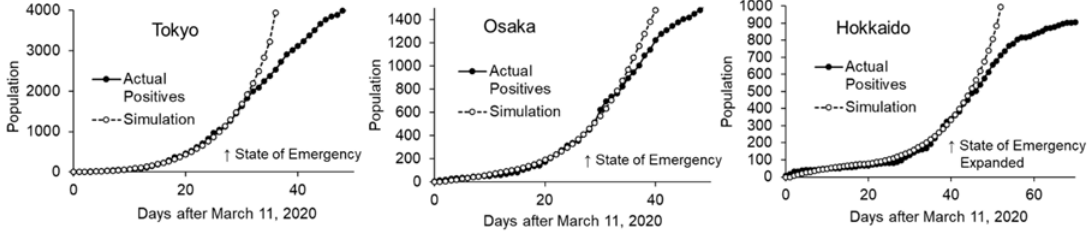
Figure 4. Simulation without intervention and actual patient numbers in 3 regions. 3.2.2. Effects of Interventions on Transmission Efficiency To simplify the analysis, the effects of interventions were combined with isolation effect and the parameter; transmission efficiency was computed as an endogenous parameter. Curve fitting was done in a sequential manner, from earlier timeframe to later timeframe, assuming that intervention was done sequentially. After the curve fitting in the intervention phase, transmission efficiency under intervention was reduced by 75% (25% remaining efficiency) in Tokyo, which started in early April (when the state of emergency was declared) (Figure 5, left). In Osaka, in addition to the first reduction in early April, the second phase started at the end of April when the Japanese holiday season began. Transmission efficiency was reduced by 60% and 85% (40% and 15% remaining efficiency) in the first and second phase, respectively (Figure 5, center). In Hokkaido, where a regional state of emergency had been declared in February 2020 and was lifted in the middle of March, transmission efficiency decreased to 68% (32% remaining efficiency) at the end of March. Subsequently, it increased to 90% at the end of April (10% remaining efficiency), two weeks after the inclusion of the region in the state of emergency (in the middle of April) and at the beginning of the holiday season (Figure 5, right). Net remaining transmission efficiency relative to baseline under the best intervention was 25%, 17%, and 31% in Tokyo, Osaka, and Hokkaido, respectively. Under this real condition, no overflow in virus testing or hospital capacity was observed.